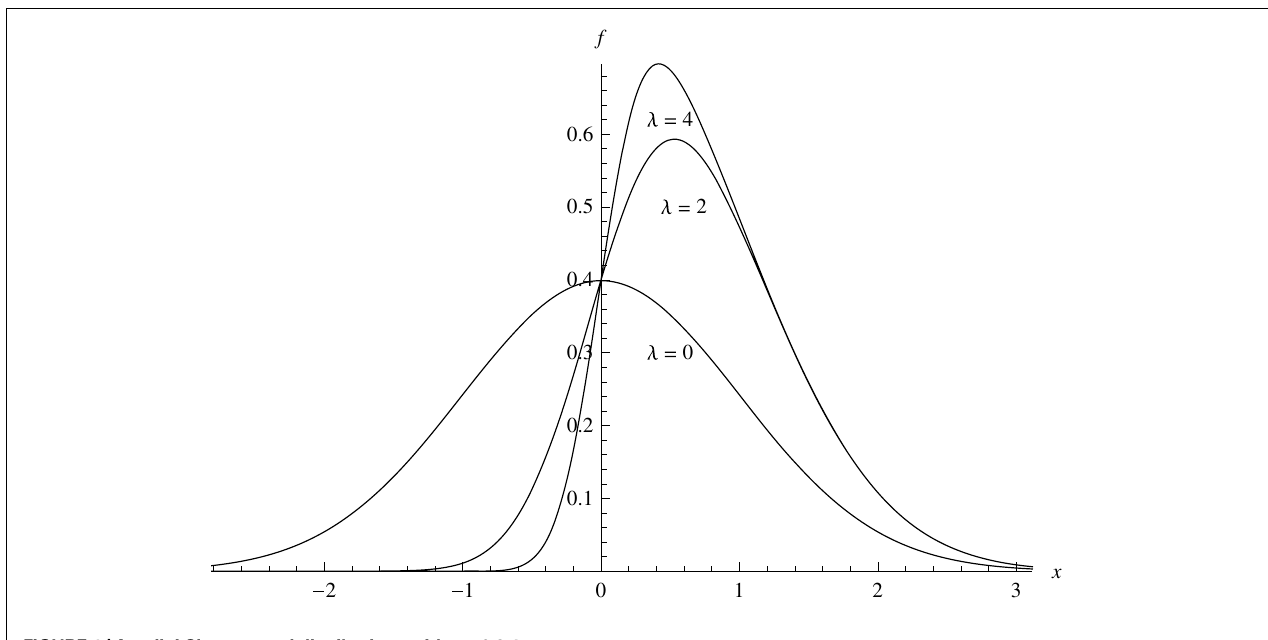
FIGURE 1 |Azzalini Skew-normal distributions with λ = 0,2,4.